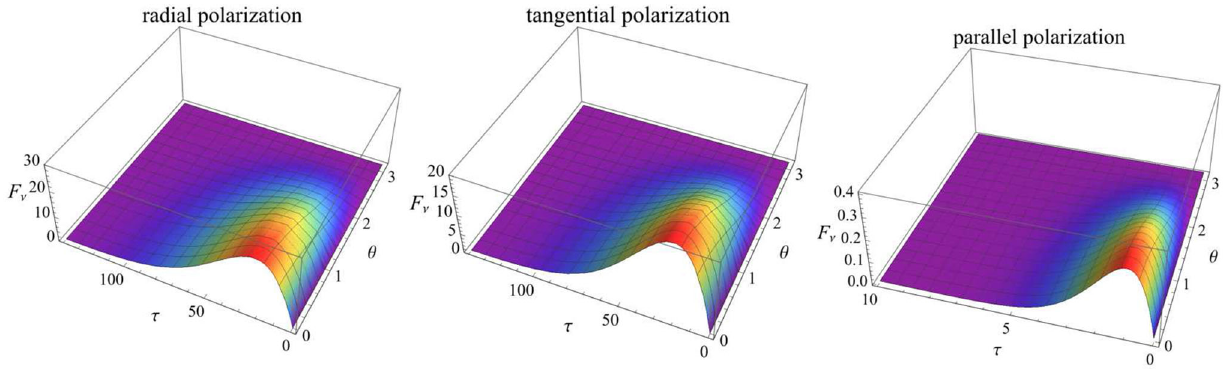
r = 0 . 1 and the deficit angle parameter ν = 1 . 5. Here F ν and ν are dimensionless. θ is the state parameter, which is expressed in radian. τ and r are also dimensionless by rescaling, actually r is in the unit of c τ is in the unit of 1 ω 0 , and γ 0